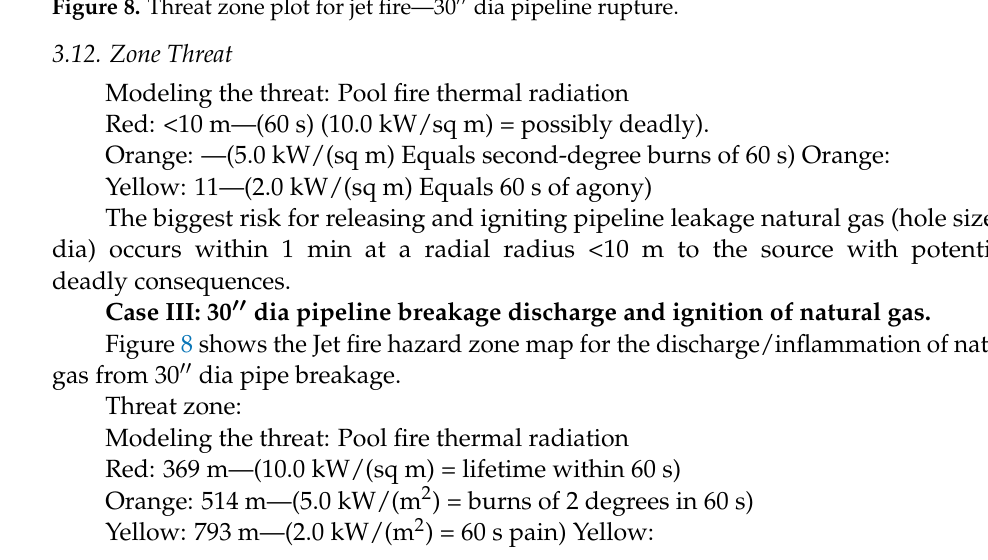
Figure 8. Threat zone plot for jet fire — 30 ″ dia pipeline rupture.